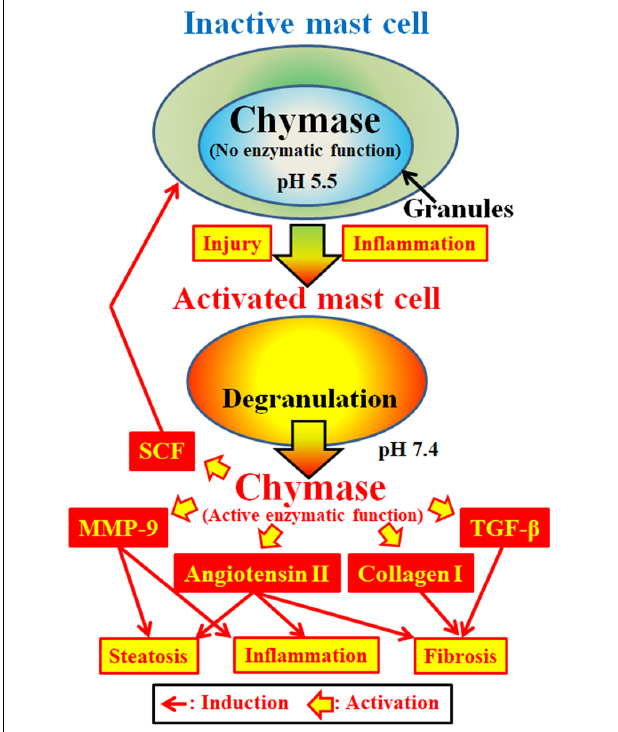
FIGURE 2 | Chymase is stored in the secretory granules of inactive mast cells. The pH within granules is maintained at pH 5.5, a condition in which chymase has no enzymatic activity. Chymase exhibits its enzymatic functions, such as formation of angiotensin II, MMP-9, TGF- β , collagen I and SCF, upon release from mast cell granules, following activation by inflammation and